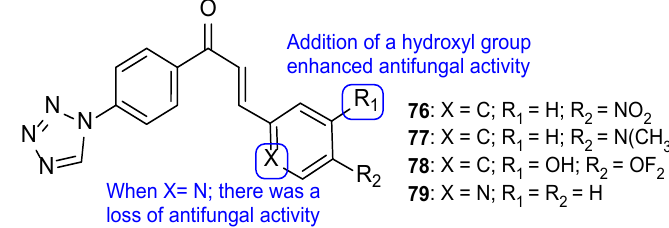
Figure 39. Chemical structures for compounds 76 – 79 , and SAR [119]. Dofe et al. synthesized a novel series of tetrazole-flavone compounds and assayed for antifungal activity using the broth microdilution method against C. albicans , C. glabrata , and C. tropicalis . All tested compounds presented higher antifungal activity than the standard miconazole against C. glabrata and C. tropicalis . When tested against C. albicans , compounds 80 and 81 (Figure 40) showed promising antifungal activity, comparable to that of miconazole (MIC = 32.6, 32.3, and 30 µM, respectively). It was noted that substitu- tions in C-6 and C-8 on the phenyl ring with methyl and chlorine did not increase the antifungal activity, when compared to the unsubstituted ring (compound 80 ) (Figure 40). In addition, all tested compounds inhibited biofilm formation [120]. O O